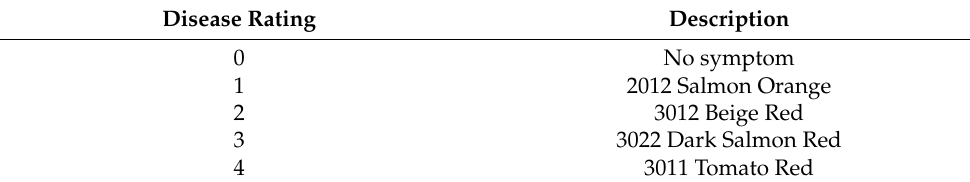
Table 4. The disease rating of reddish discoloration of cucumber fruitlets (developed from this study).